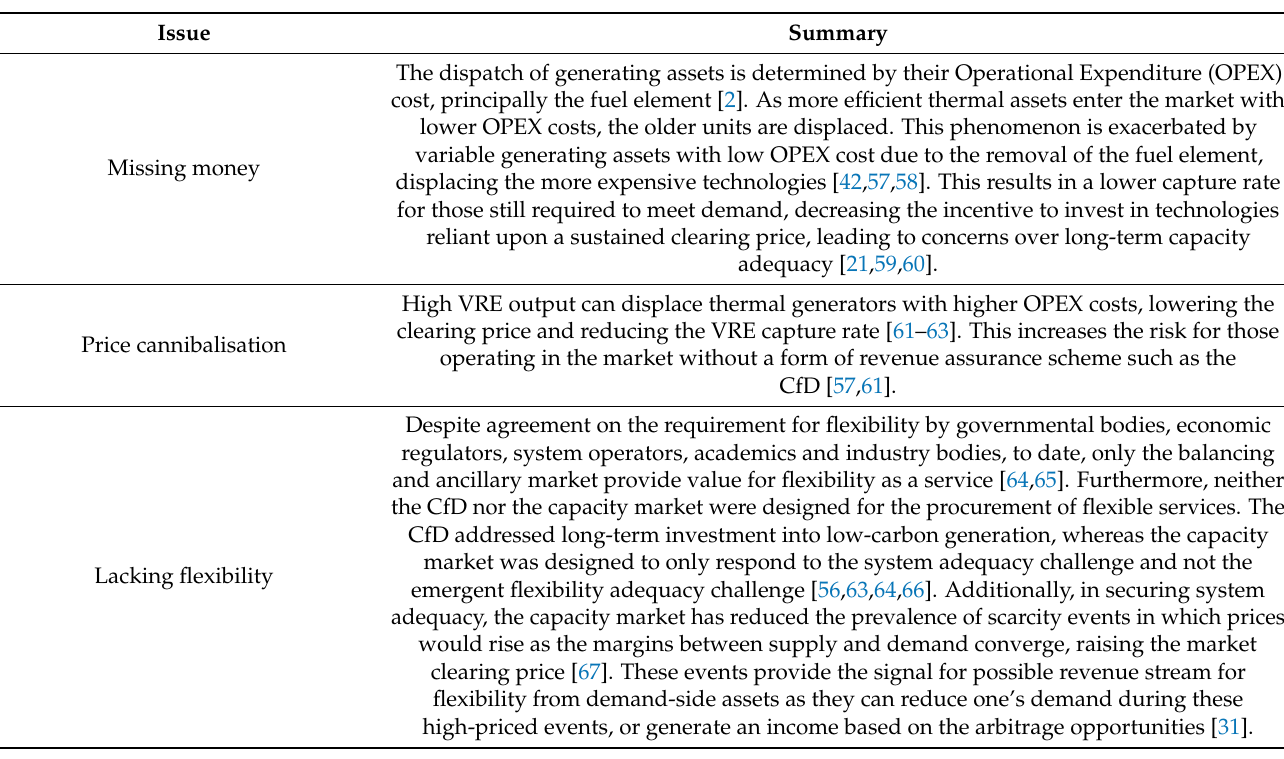
Table 1. Summary of several issues associated with the current electricity market